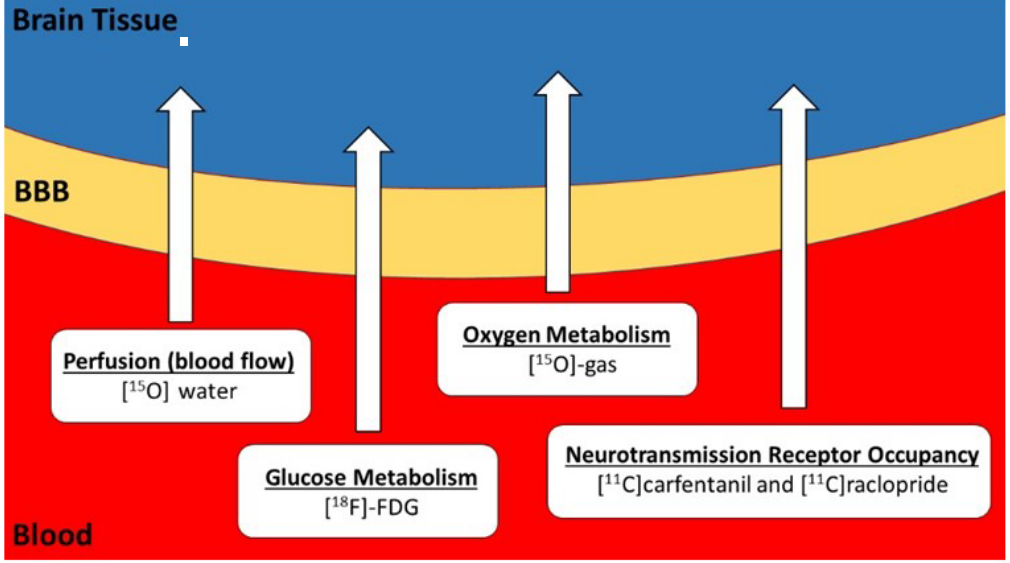
Figure 1. Potential PET tracers available for combination with tDCS. Glucose is the most important energy resource of the human brain and its metabolism can be measured and quantified using positron emission tomography (PET) with [ 18 F]-fluorodeoxyglucose (FDG). Oxygen is necessary for the operation of the tricarboxylic acid cycle to synthesize ATP molecules from glucose, and oxygen metabolism can be measured using PET with [ 15 O]-oxygen gas during inhalation. Glucose and oxygen molecules are supplied by blood flow. Brain regions with increased activity are accompanied by regional capillary dilation and increased regional cerebral blood flow (rCBF), which can be measured with [ 15 O]water PET. The interaction of neurotransmitters and receptors can also be measured using PET with various [ 11 C]-labeled ligands, such as [ 11 C]carfentanil and [ 11 C]raclopride. BBB = blood brain barrier.